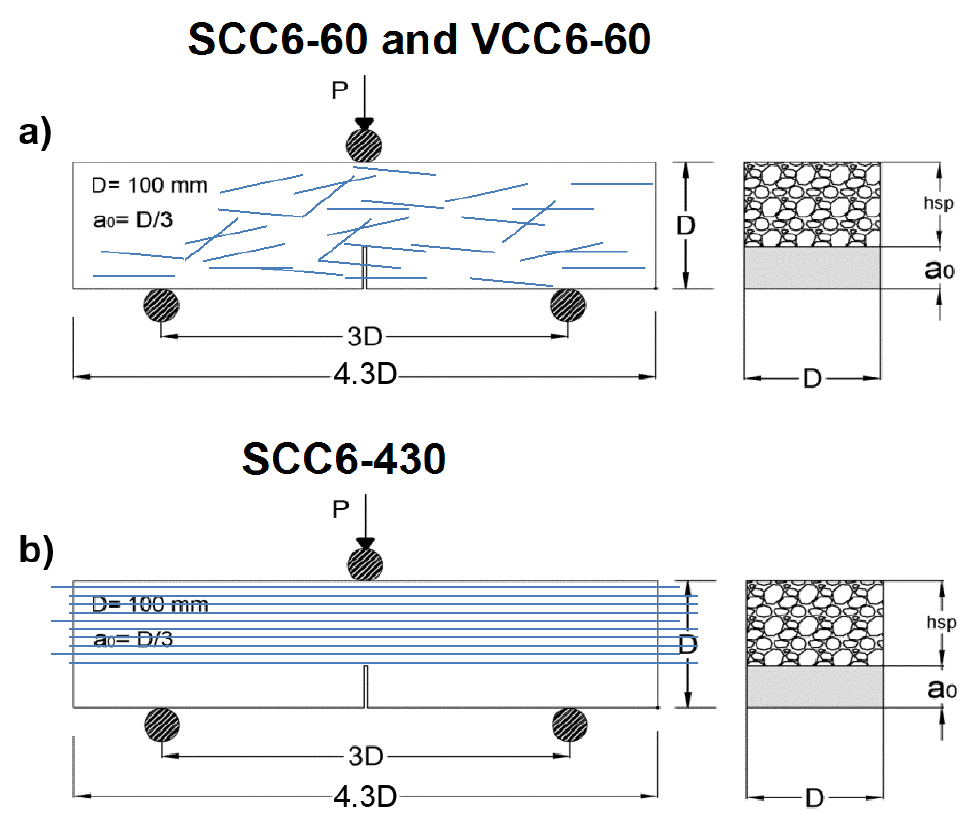
Figure 4. ( a ) Test geometry in the case of fibers randomly positioned; ( b ) test geometry in the case of fibers being aligned in the stress direction and homogeneously distributed.